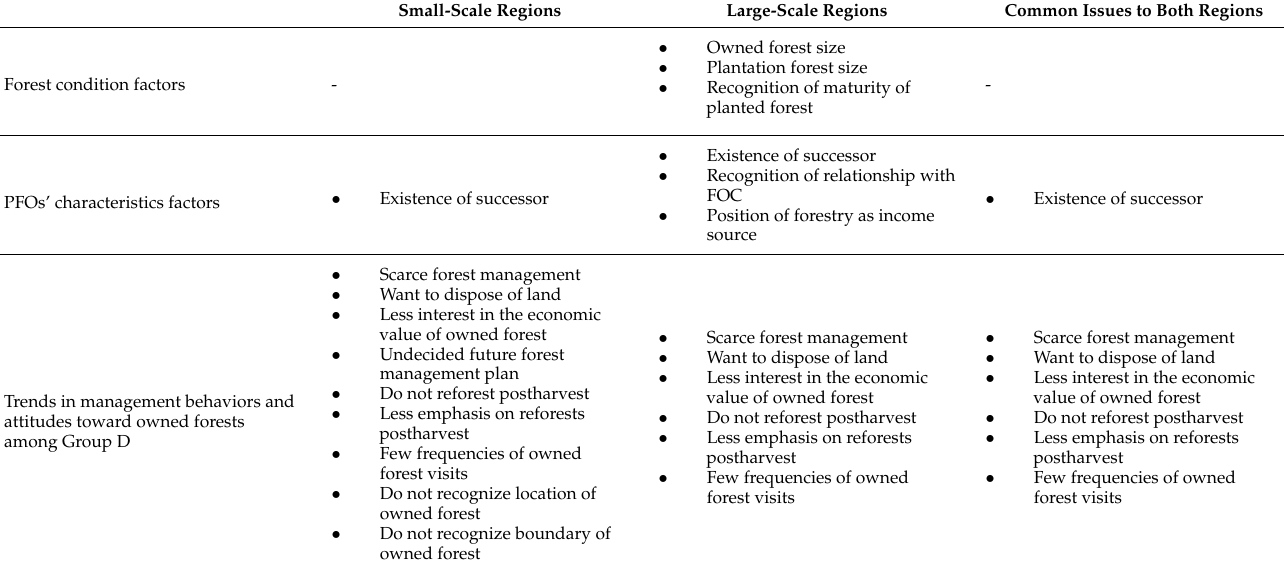
Table 13. The factors affecting the PFOs’ future intention, tendency of D group’s forest manage- ment